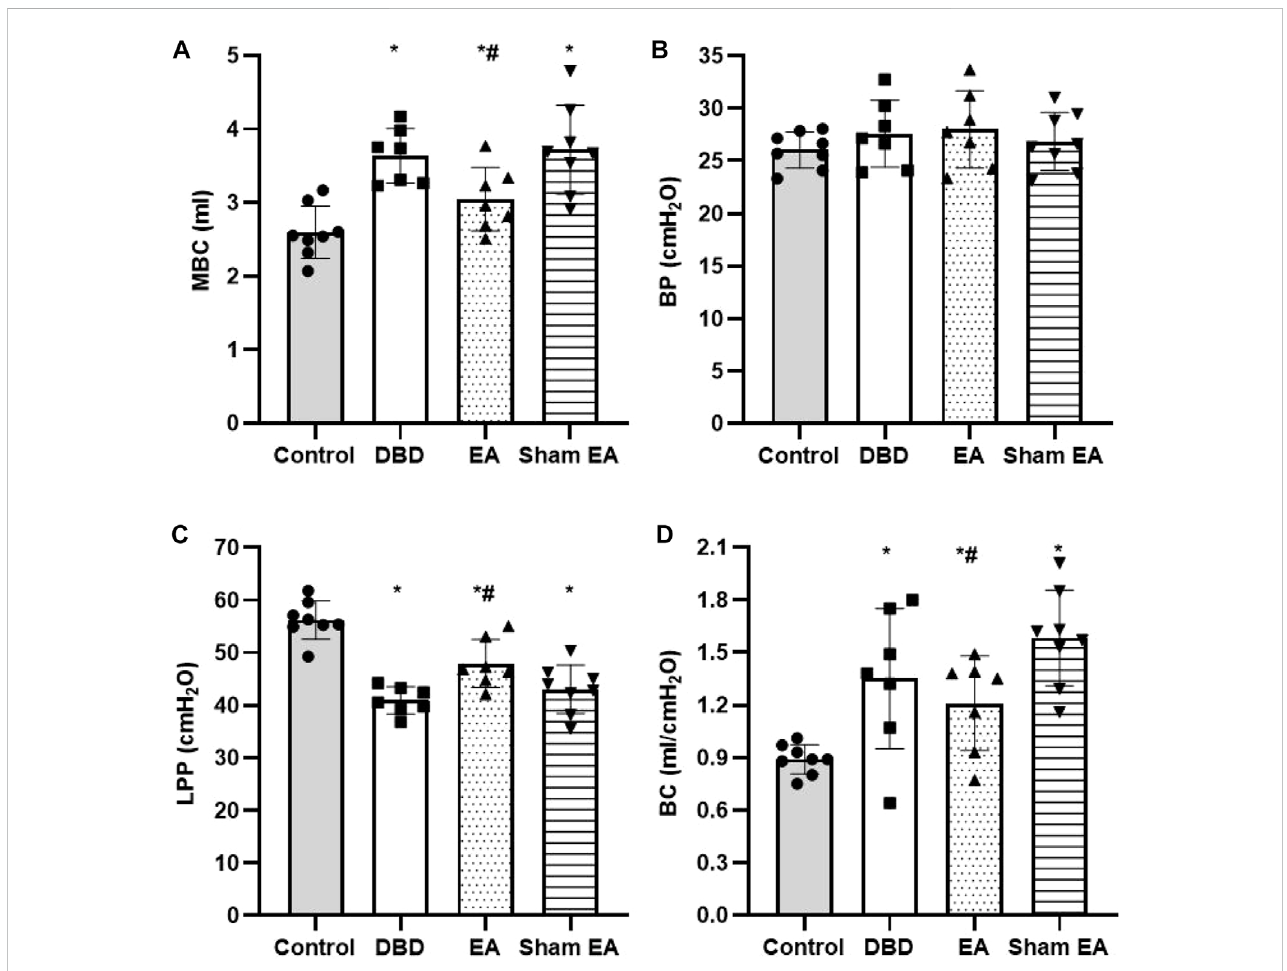
FIGURE 4 Comparison of cystometry parameters in a urodynamic test. The results of bladder wall thickness (e) in the ultrasonography test. (A) MBC: maximum bladder capacity; (B) BP: basal Pressure; (C) LPP: leakage point pressure; (D) BC: bladder compliance. Control: n = 8 rats, DBD: n = 7 rats, EA: n = 7 rats, Sham EA: n = 8rats. Results are expressed as mean ± standard error ofthe mean. * p < 0.05 versus the Control group. # p < 0.05 versus the Sham EA group (one-way